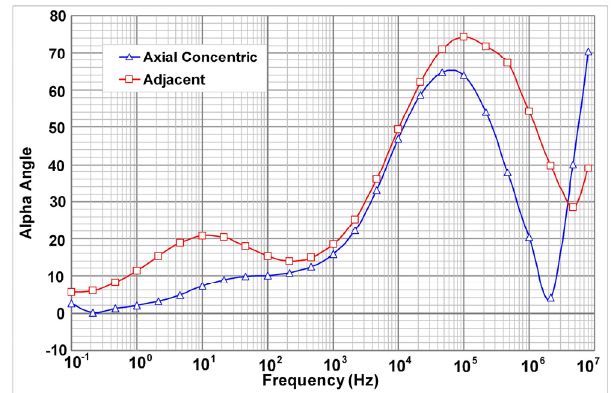
Figure 6: IEA angle. ( Δ : values obtained with axial concentric electrode shape, □ : values obtained with adjacent electrode